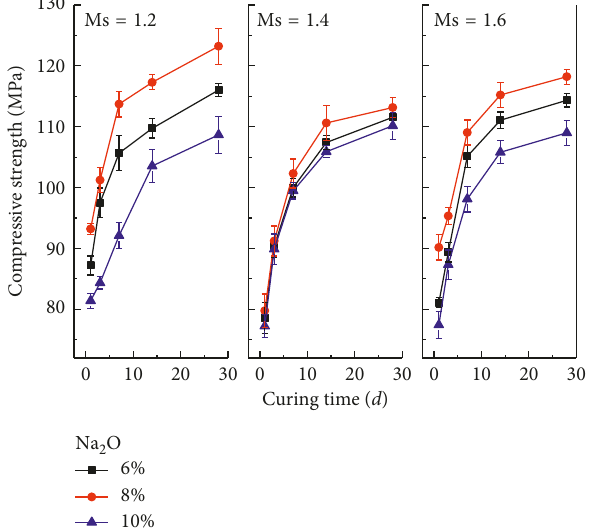
Figure 9: The effect of silicate moduli and Na 2 O contents on the mass loss of AAS mortars.